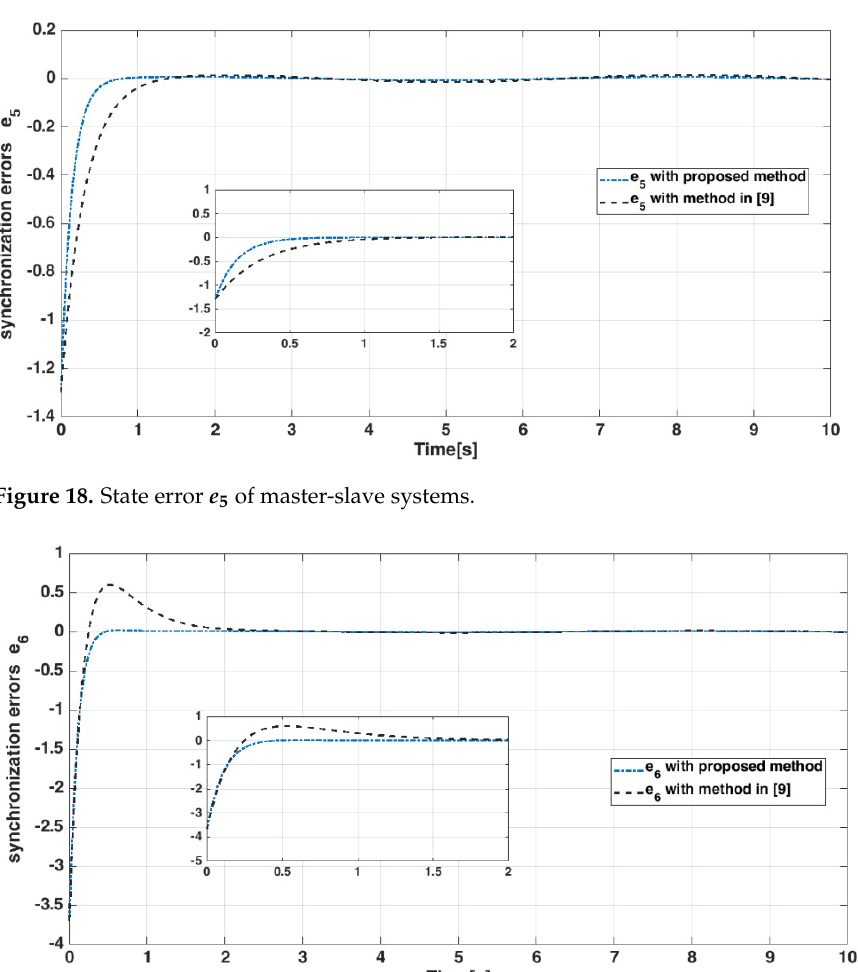
Figure 17. State error e 4 of master-slave systems.